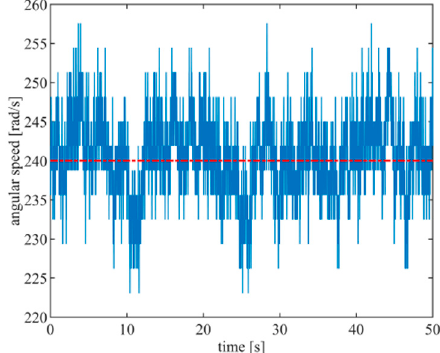
Figure 4. Time sequence of the measured angular speed in PDM in the ABL (atmospheric boundary layer) wind tunnel. The red dash–dotted line denotes the mean angular speed.